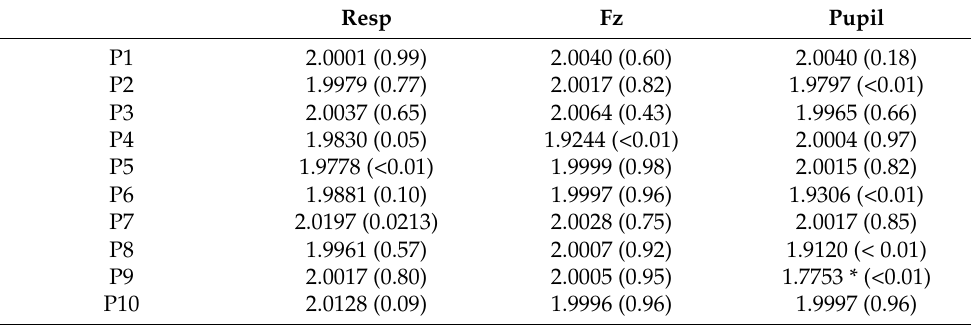
Table 5. Durbin-Watson results for whiteness of residuals. Values in bold exceeded DW critical values, but were within tolerances suggested by the original authors of the MVGC method]. All values exceeding critical DW values (bold) were however within the range 1.91 < DW < 2.1, with the exception of a single participant’s (*) pupil model residuals (DW = 1.78). In line with the tolerances used in the original study, 80% of residuals showed no significant autocorrelation, indicating the autoregressive models were overall sufficient to account for the autocorrelation present in the time